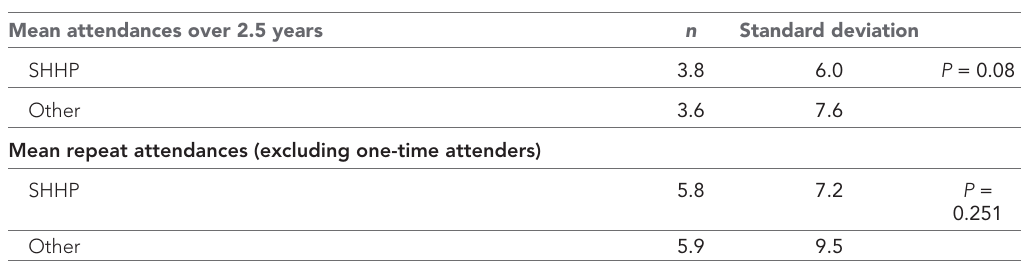
Mean attendances over 2.5